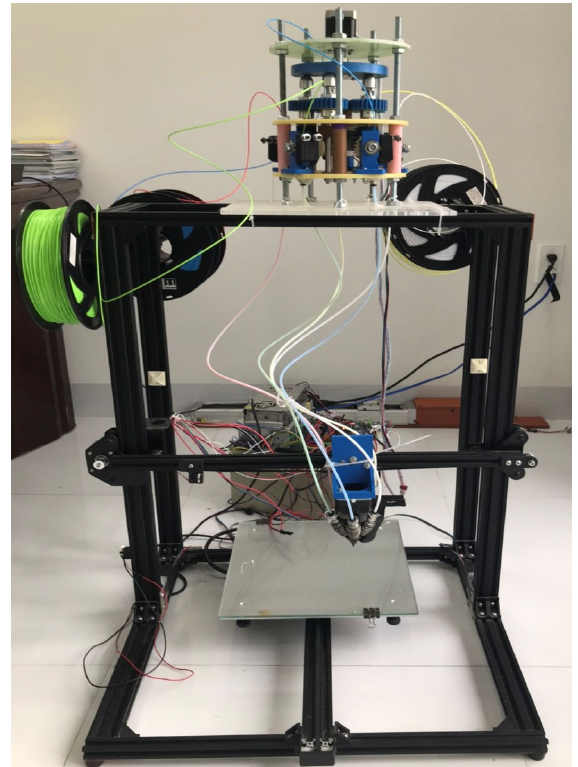
Figure 6. The prototype of the proposed multicolor 3D printer.